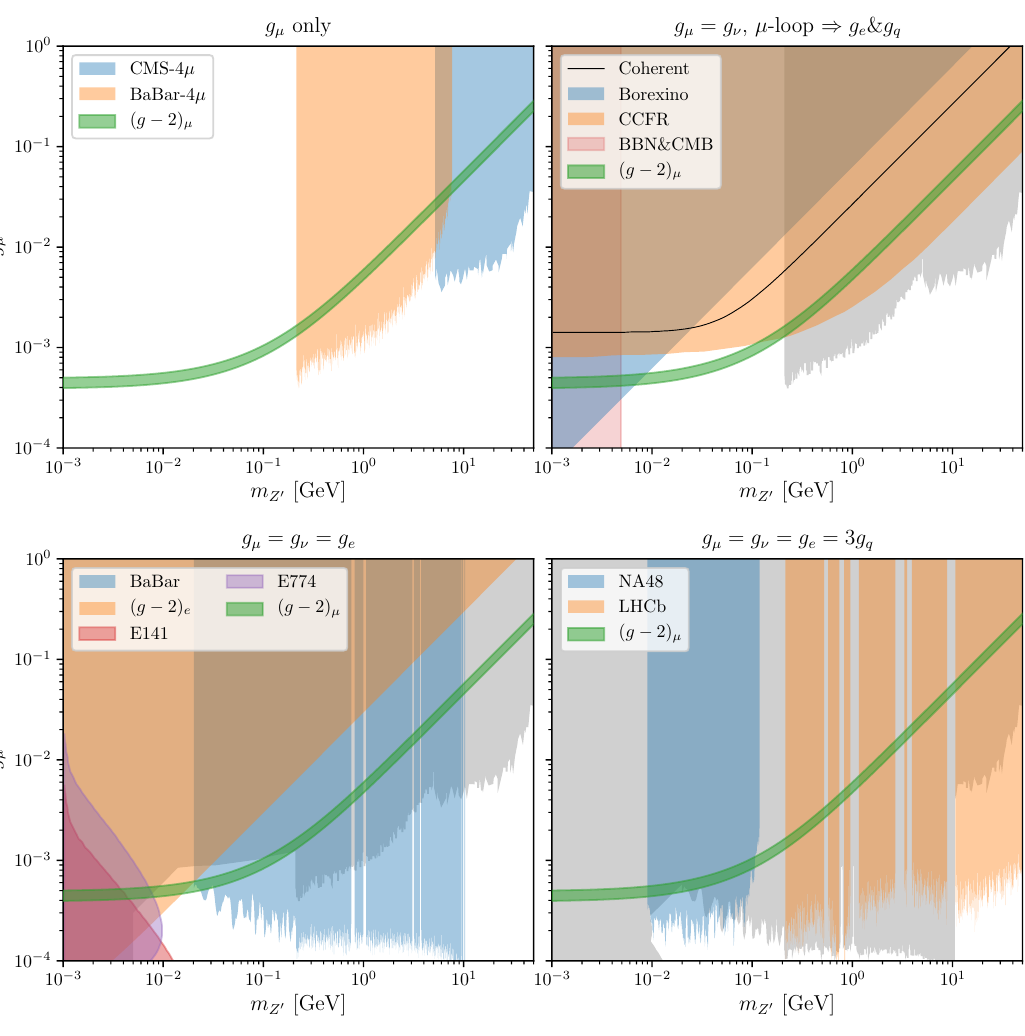
Figure 2 . Current viable parameter spaces for the Z 0 when it couples exclusively to µ (upper left), couples equally to µ and ν (upper right), couples universally to leptons (lower left), or couples µ,L to all SM fermions (lower right). The green band reduces the muon g − 2 anomaly to within 1 σ . Grey bounds correspond to ones already introduced in previous